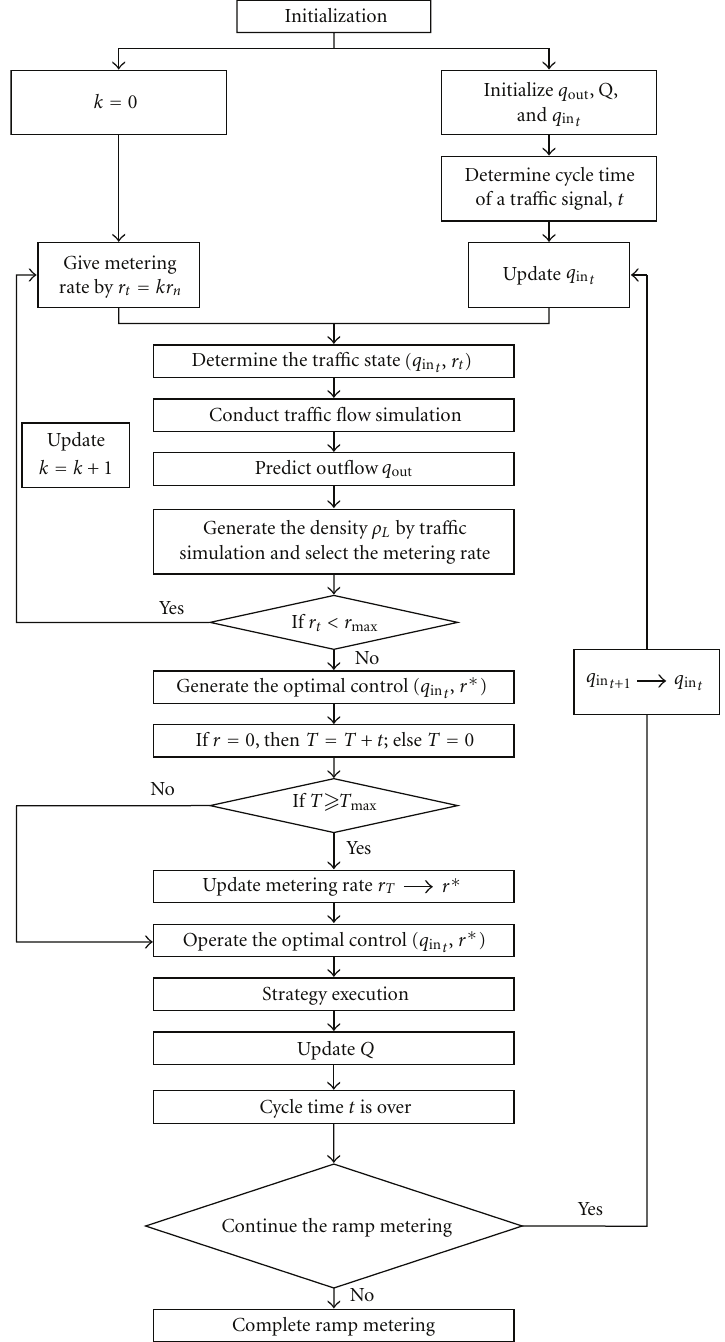
Figure 5: Algorithm of reinforcement learning ramp